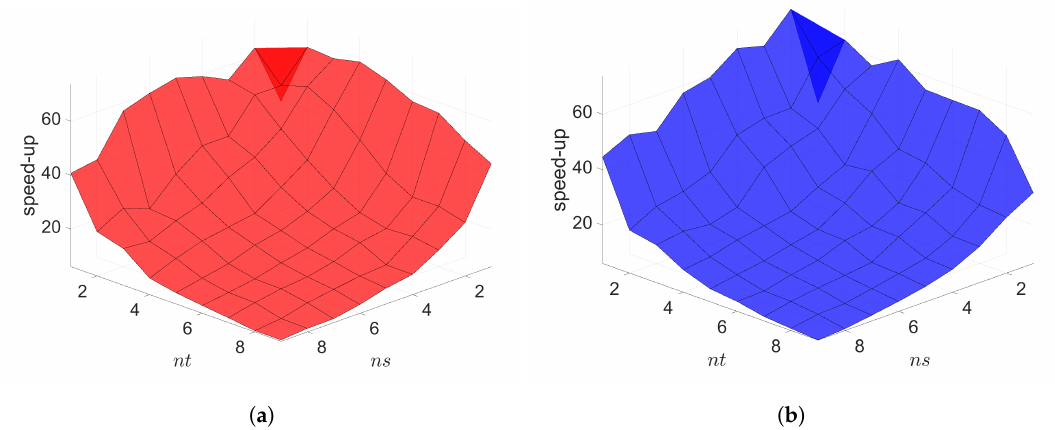
Figure 7. 2D linear diffusion equation. Solving speed-ups vs. reduced dimensions. ( a ): Solving speed-ups vs. reduced dimensions for Galerkin projection, ( b ): Solving speed-ups vs. reduced dimensions for LSPG projection. The final time snapshots of FOM, Galerkin space–time ROM, and LSPG space–time ROM are seen in Figure 8. Both ROMs have a basis size of n s = 5 and n t = 3,